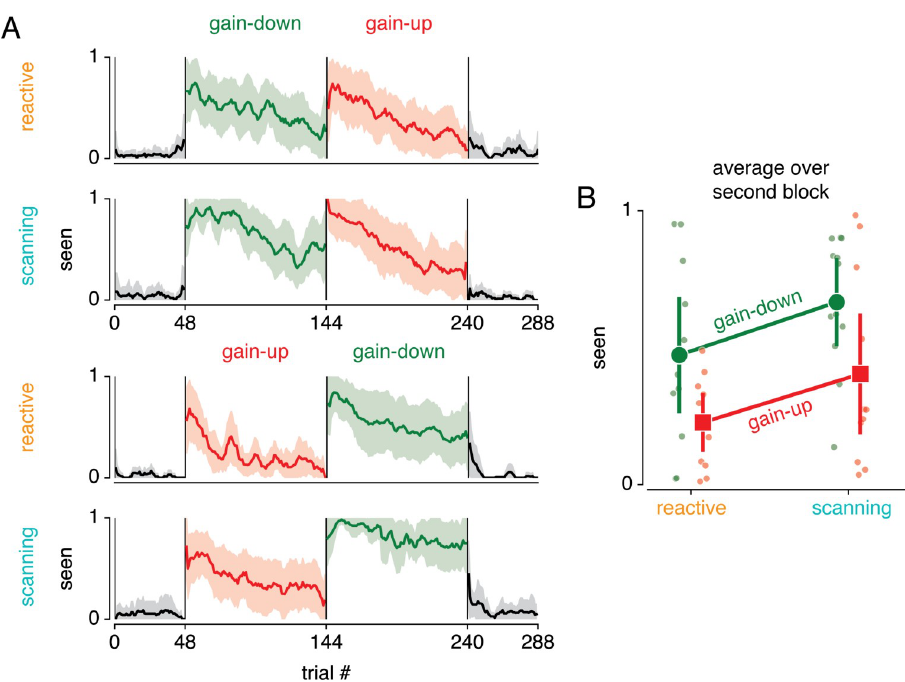
Fig 8. Saccade target displacement awareness. (A) Across participant average of binary displacement awareness (i.e. seen versus unseen) across the experiment, shown as running average over 6 saccades (the hexagonal period). Shaded areas correspond to 95% CI over participants. This verifies that a target displacement was not seen in the baseline blocks (i.e. blocks 1 and 4 colored black). In addition, it shows that target displacement was seen more often at the beginning compared to the end of an adaptation block. (B) Average displacements awareness per condition in the second block. The target displacement was perceived more often in gain-down compared to gain-up adaptation, and more often in scanning compared to reactive saccade conditions (see main text for